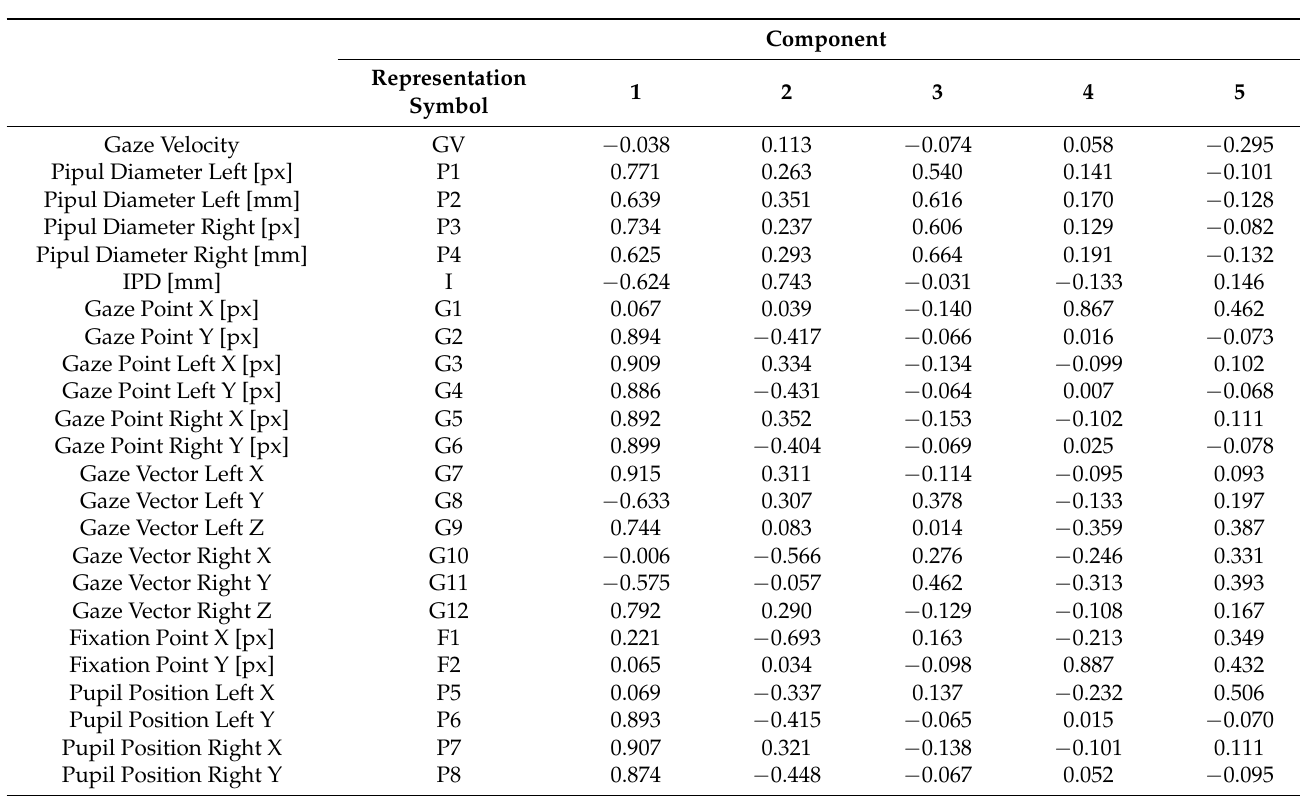
Table 8. Composition matrix of the simulated driving test